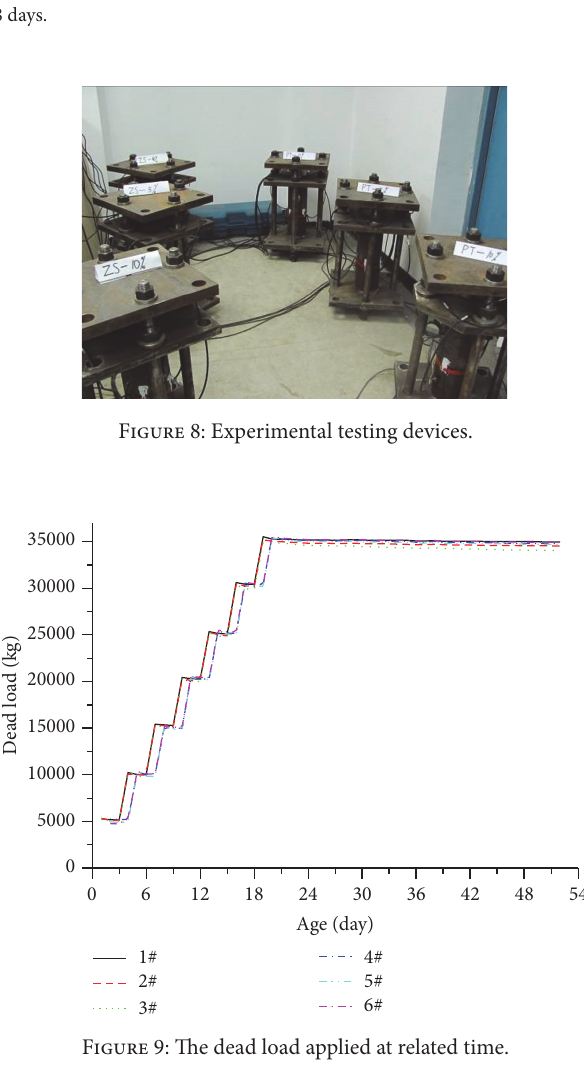
three columns in each group, respectively. The design details of the columns are shown in Table